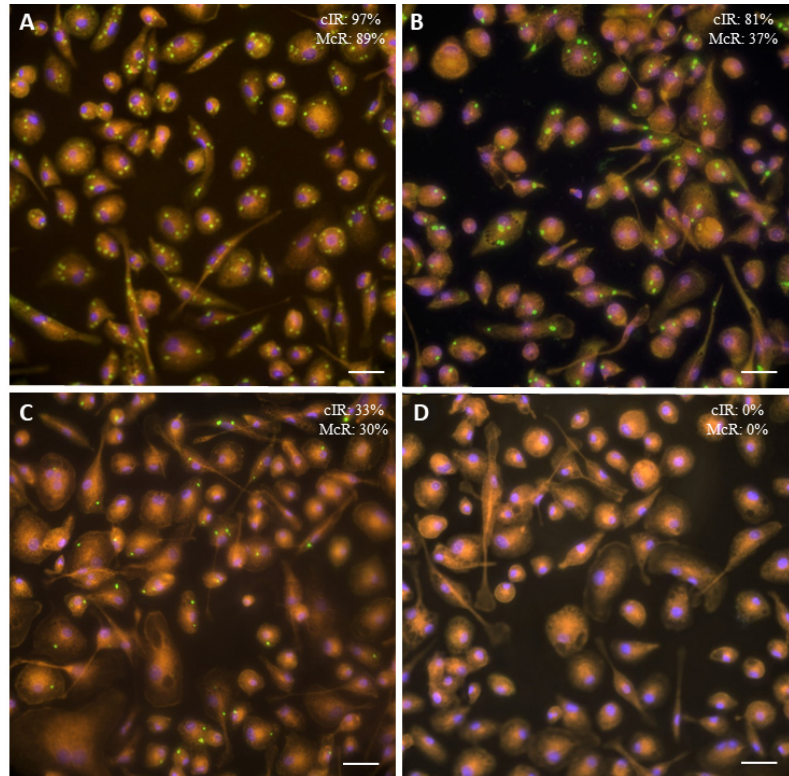
Figure 1. Immunofluorescence of OvMØs at different rates of infection with Toxoplasma gondii tachyzoites: ( A ) high rate (Type III isolate); ( B ) medium rate (PRU II-C group); ( C ) low rate (PRU II-A group); ( D ) uninfected OvMØs. Toxoplasma gondii tachyzoites (green—Alexa Fluor 488), cytoplasm (orange—TRITC), and nuclei (blue—DAPI) are shown. cIR: cell infection rate; McR: multi-infected cells. Scale bars = 50 µm.